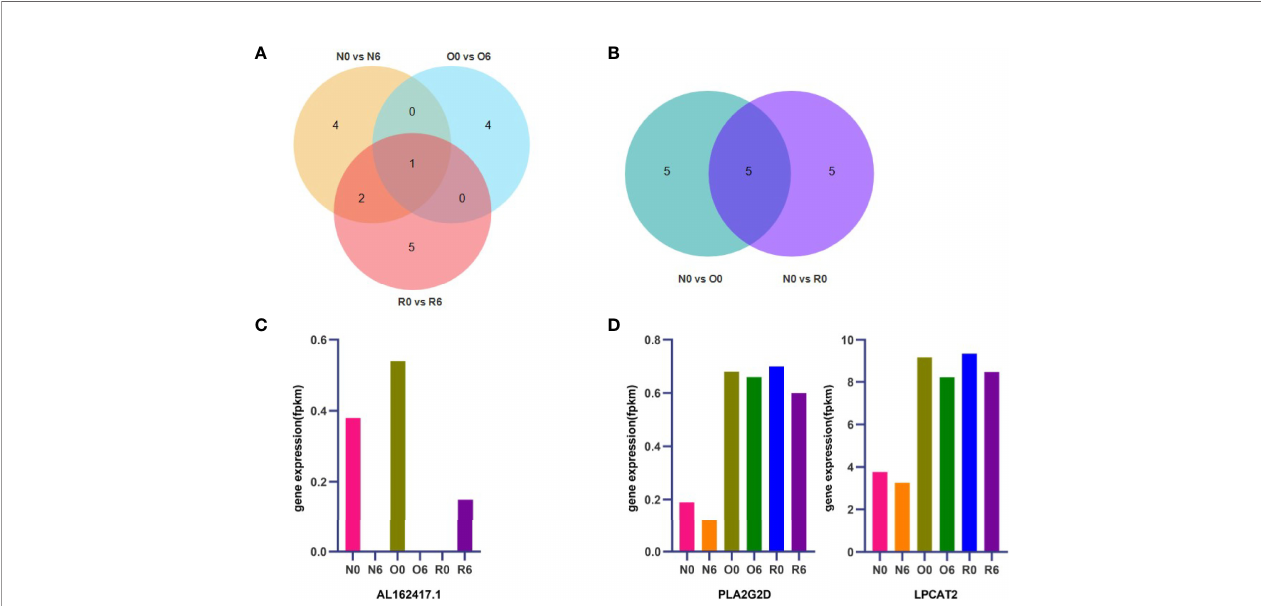
FIGURE 5 | AL162417.1, PLA2G2D , and LPCAT2 are candidate genes for drug ef fi cacy and resistance. The core genes of drug ef fi cacy and resistance related pathways identi fi ed by KEGG enrichment analysis and the shared key genes were found by Venn diagram (A, B) . Expression of key genes for drug ef fi cacy and resistance were detected by RNA-seq (C, D)